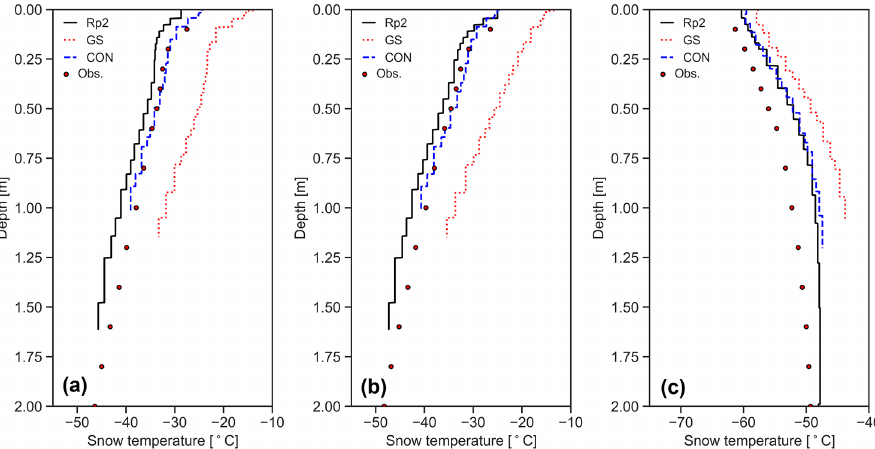
Figure 4. Subsurface snow temperature profile for Dome C in 2007 for the 20 upper snow layers of Rp2, GS and CON and observations (Obs.) for (a) 5 January, (b) 17 January and (c) 5 April, all measured at 06:00UTC